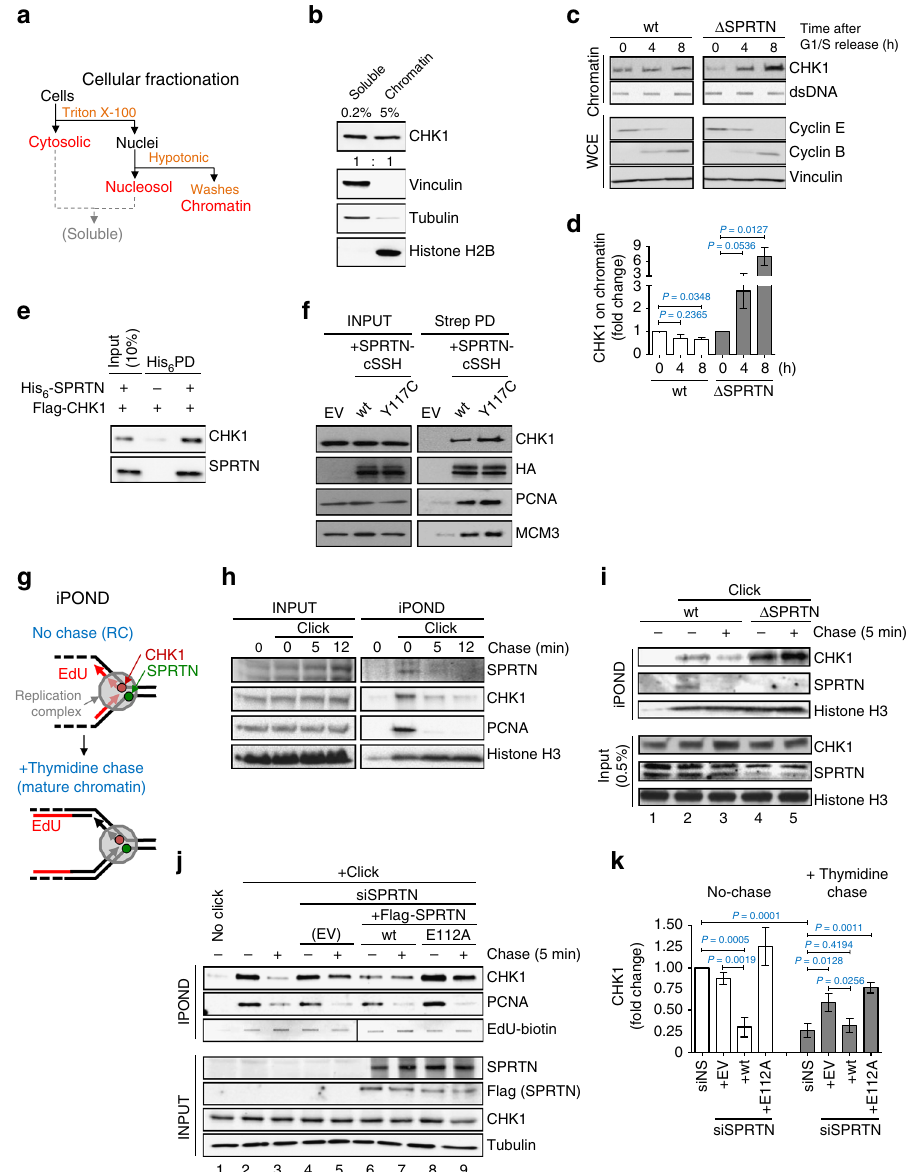
Fig. 4 SPRTN protease evicts CHK1 from replicative chromatin. a Diagram of cellular fractionation into cytosolic, nuclear and chromatin fractions. The chromatin fraction was thoroughly washed with 1% NP-40 and 250 mM NaCl to isolate clean chromatin. b The cleanliness of the chromatin fraction was con fi rmed by fractionation protein markers. c , d SPRTN de fi ciency leads to accumulation of tightly bound CHK1 on chromatin during the S-phase progression. HeLa-wt and HeLa- Δ SPRTN cells were arrested at the G1/S boundary by a double thymidine block and then released to progress through S- phase. c Proteins tightly bound to DNA were isolated by a modi fi ed RADAR assay and the total content of CHK1 tested by immunoblotting. Double- stranded DNA (dsDNA) was used as loading control. Cyclin E and cyclin B from whole cell extracts (WCE) were used as cell cycle markers. d Quanti fi cation of CHK1 in ( c ). Mean ± SEM; n = 2, two-tailed Student's t -test. e SPRTN and CHK1 interact physically in vitro. Puri fi ed CHK1 co- precipitated with recombinant His 6 -tagged SPRTN on Ni-NTA beads. Immunoblots represent three replicates. f SPRTN and CHK1 interact physically in vivo. CHK1 co-precipitated with SPRTN from lysates of Flp-In HEK293 T-REx cells expressing either SPRTN-wt or SPRTN-Y117C fused to a cSSH (Strep-strep- HA) tag. Immunoblots represent three replicates. EV: empty vector, PD: pull down. g , h iPOND analysis revealed the presence of SPRTN and CHK1 proteins at nascent DNA (0 min) but not on mature chromatin (5 – 12 min after a thymidine chase). Cells were treated with EdU for 10 min to label nascent DNA, and then chased or not with thymidine. PCNA and histone H3 were used as replication fork and loading controls, respectively, n = 3. i HeLa- Δ SPRTN cells exhibit increased retention of CHK1 on mature DNA compared with SPRTN-pro fi cient (wt) cells. j , k SPRTN protease is necessary for the ef fi cient eviction of CHK1 from replicative chromatin. Expression of SPRTN-wt, but not of the protease inactive variant SPRTN-E112A, in SPRTN knock-down cells reduced the amount of CHK1 on replicative chromatin and reversed the accumulation of CHK1 in chased chromatin. Mean± SEM; n = 3, two-tailed Student's t -test. Source data for ( b – f , h – k ) are provided as a Source Data fi